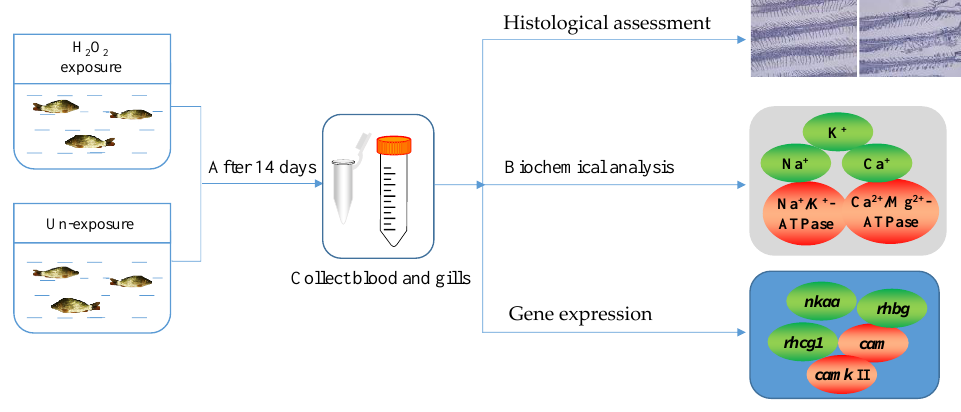
Figure 1. Flowchart of the experiment.